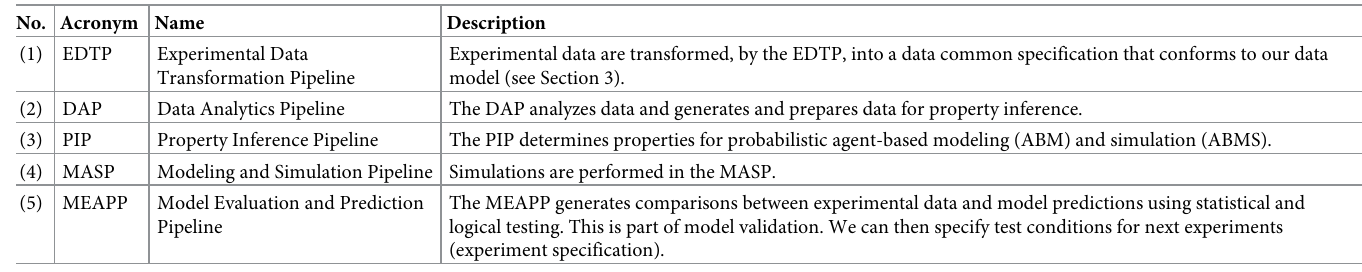
Table 1. Description of the five pipelines for NESS